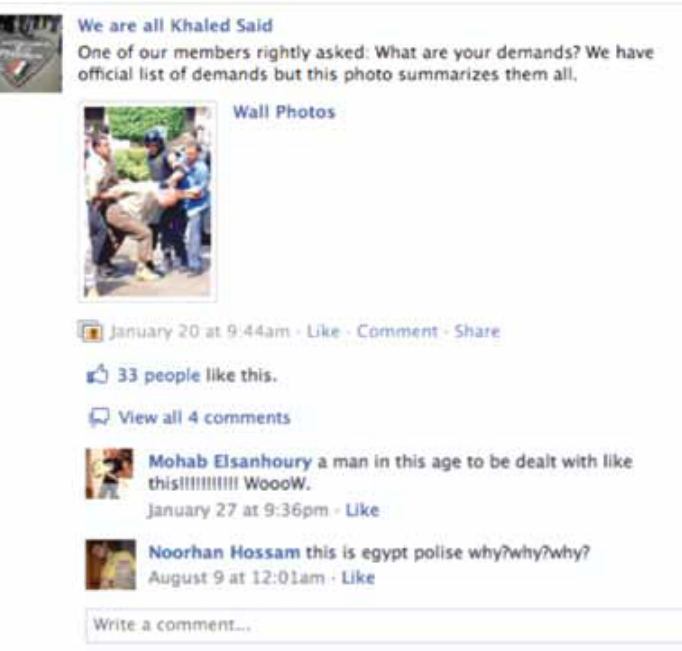
Source : WAAKS English